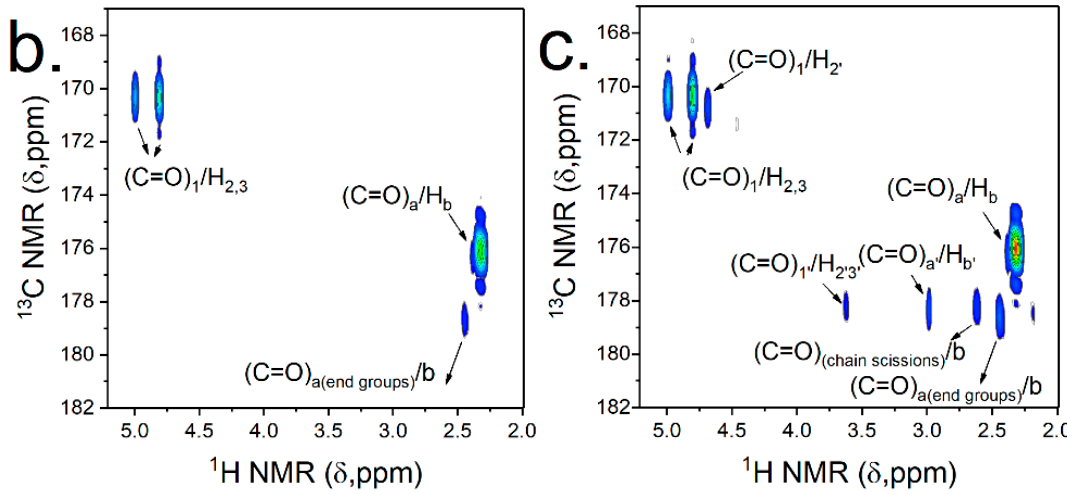
Figure 7 NMR spectra of PA(PPDA,GalXMe) 50 PA(PACM,12) 50 blends. ( a ) 1 H NMR spectra of blends